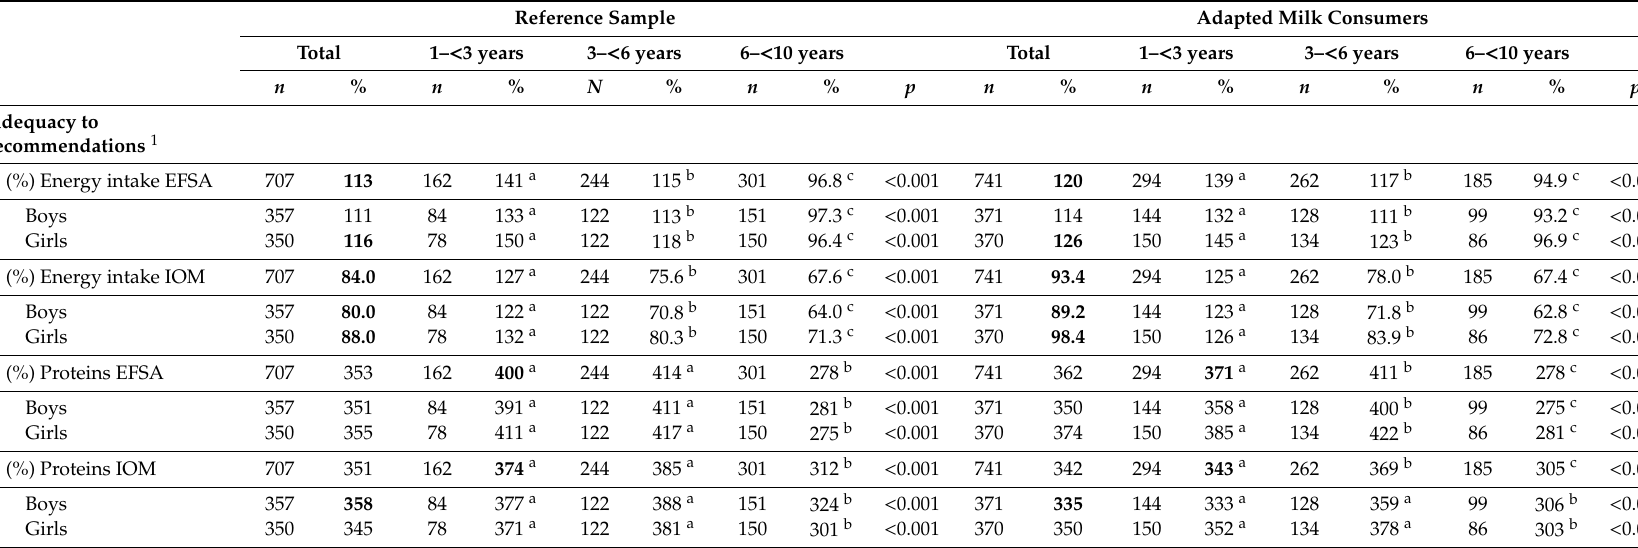
Table 5. Adequacy to the European Food Safe Authority and Institute of Medicine recommendations for energy and protein daily intakes and percentages of children that meet these criteria for fat and carbohydrates by sample, age group and sex for the Nutritional Study in Spanish Pediatric Population (EsNuPI) ( n =